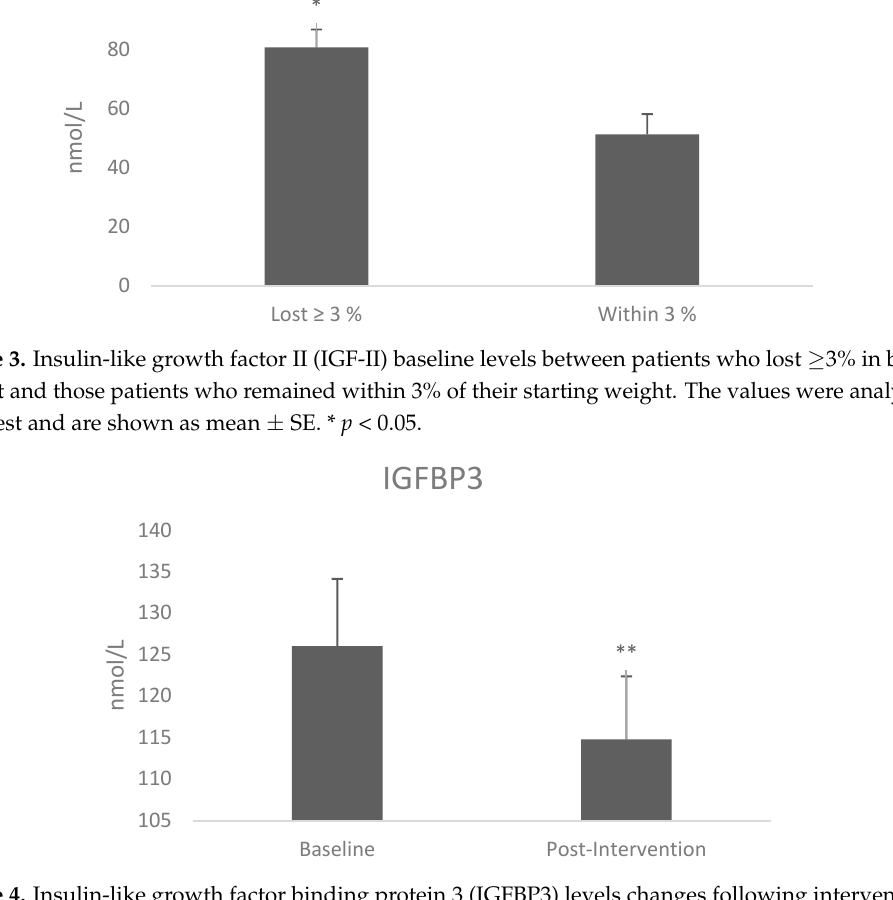
Figure 4. Insulin-like growth factor binding protein 3 (IGFBP3) levels changes following intervention. The values were analysed by paired T test and are shown as mean ± SE. ** p <